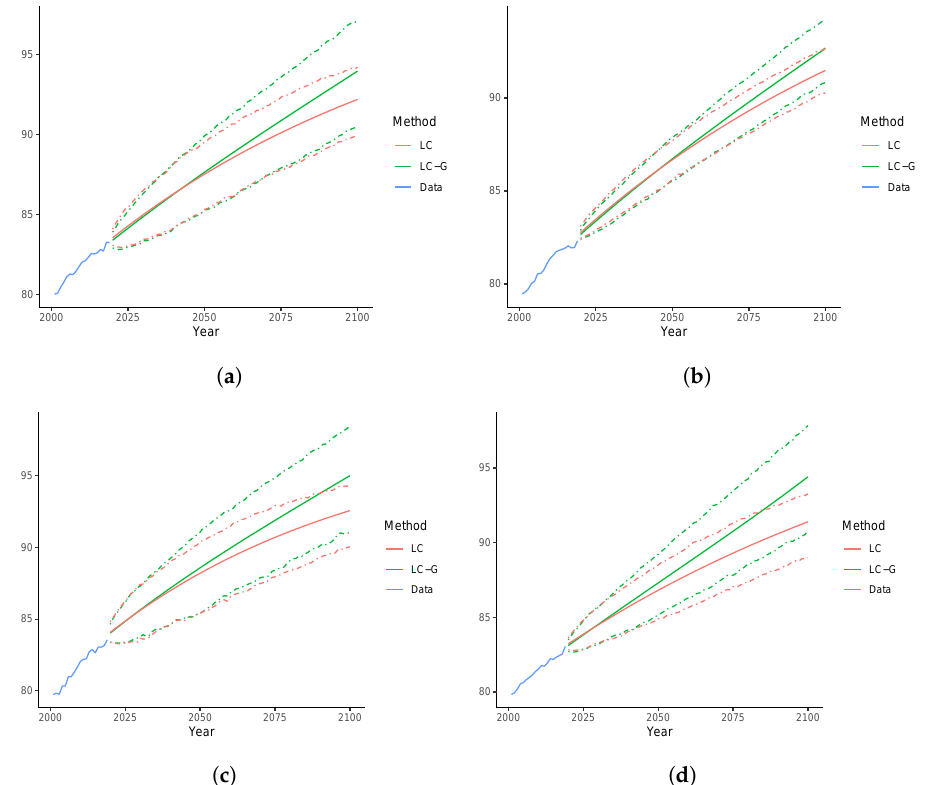
Figure 7. Forecast e 0 over 2020–2100, single-population models: ( a ) Australia; ( b ) Canada; ( c ) Spain; ( d ) Sweden.